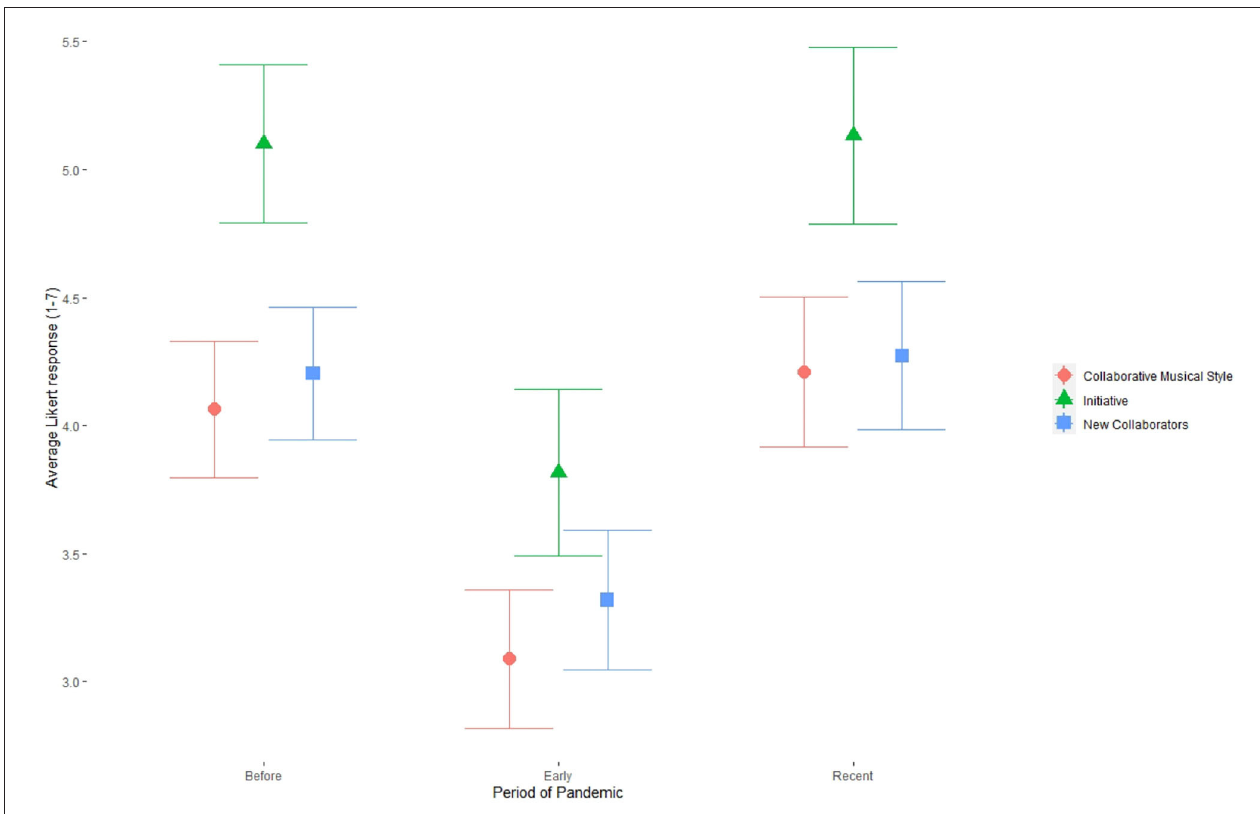
FIGURE 3 | The effect of pandemic stage on collaboration variables, showing mean and 95% confidence intervals. Collaborative Musical Style measures how much participants work with others when making their music; Initiative measures how proactive participants are when seeking collaborators; and New Collaborators measures how likely participants are to collaborate with new people. All variables were measured using 7-point Likert scales and lower values indicate a weaker fit between the variable and the music participants